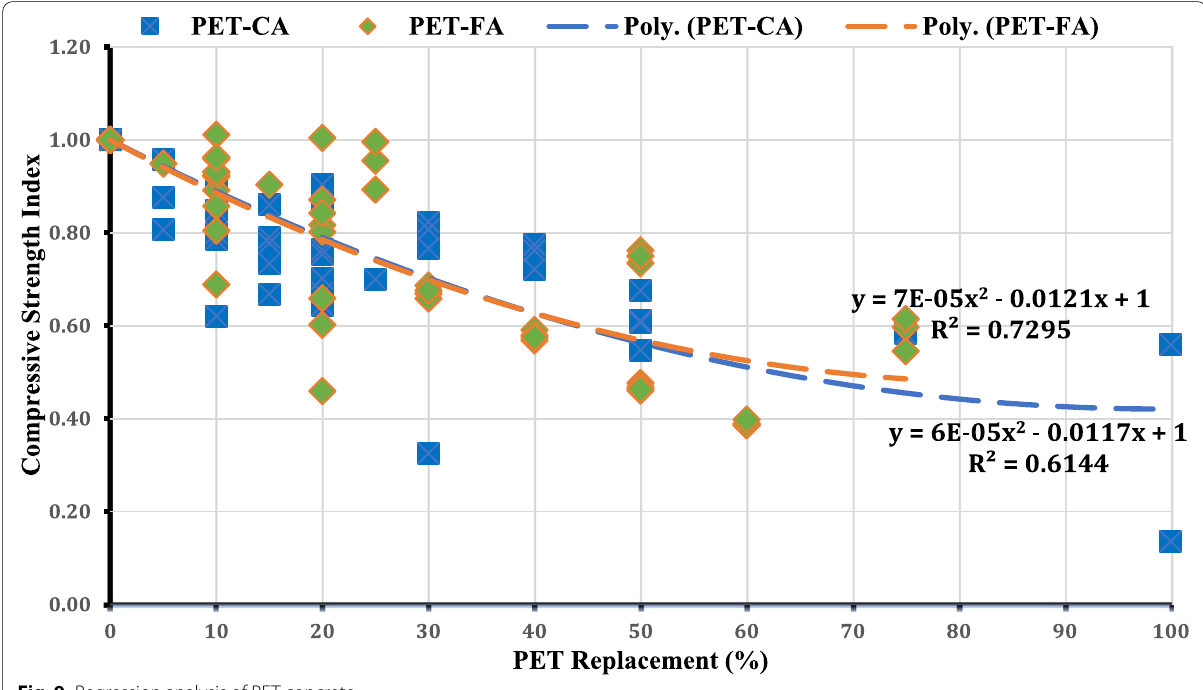
Fig. 9 Regression analysis of PET